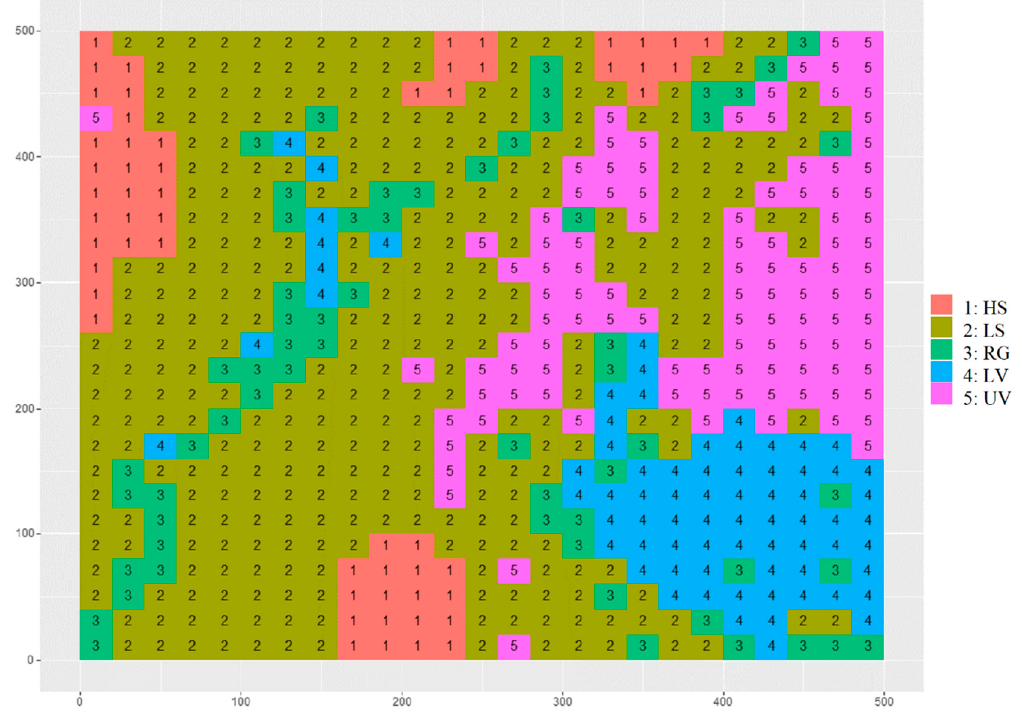
Figure 3. Habitats of the 25-ha Qinling plot based on 625 20 m × 20 m cells. HS: high-slope, LS: low-slope, RG: ridge, LV: low-valley, UV: upper-valley.